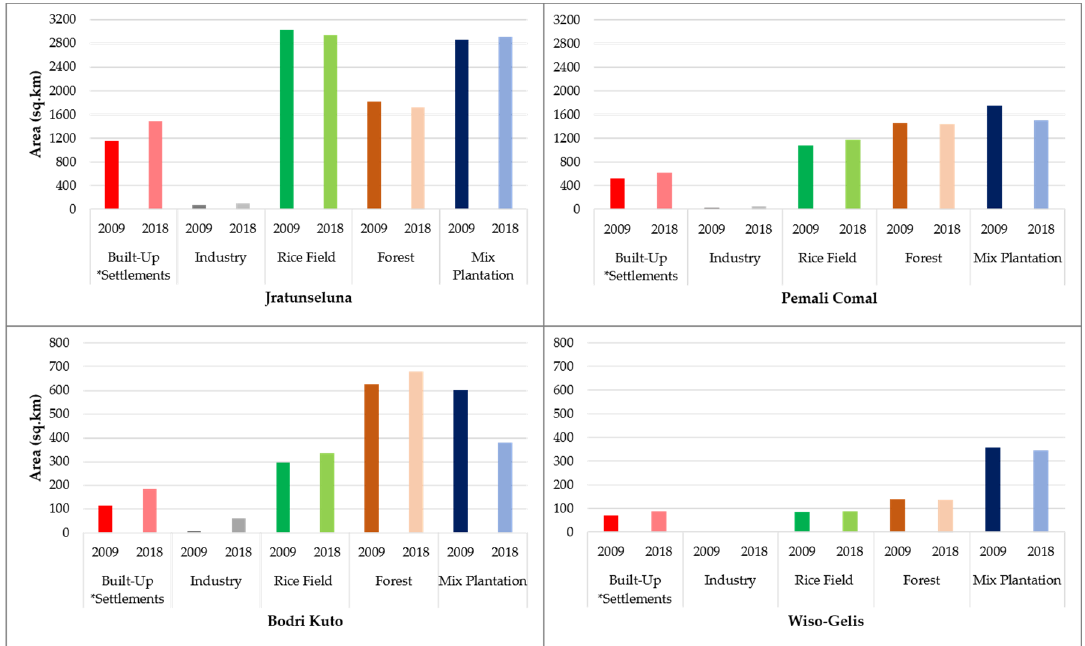
Figure 5. Land Use Change in Selected River Basins, 2009–2018.